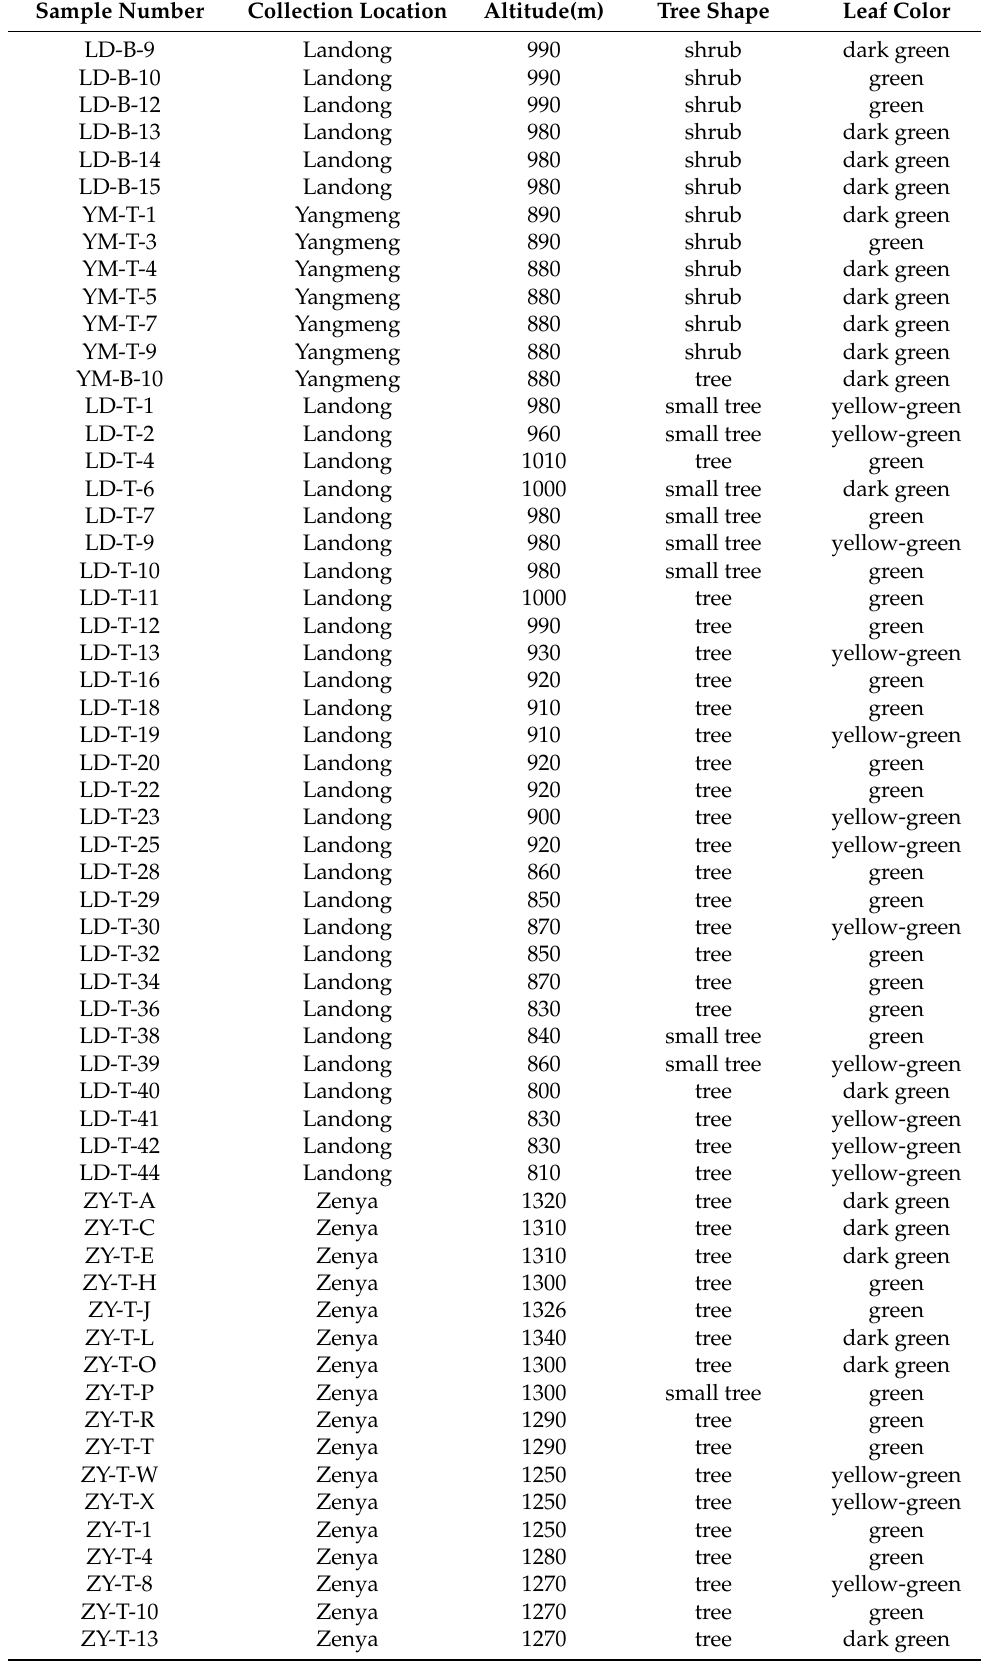
Table 1. Cont. Sample Number Collection Location Tree Shape Leaf Color